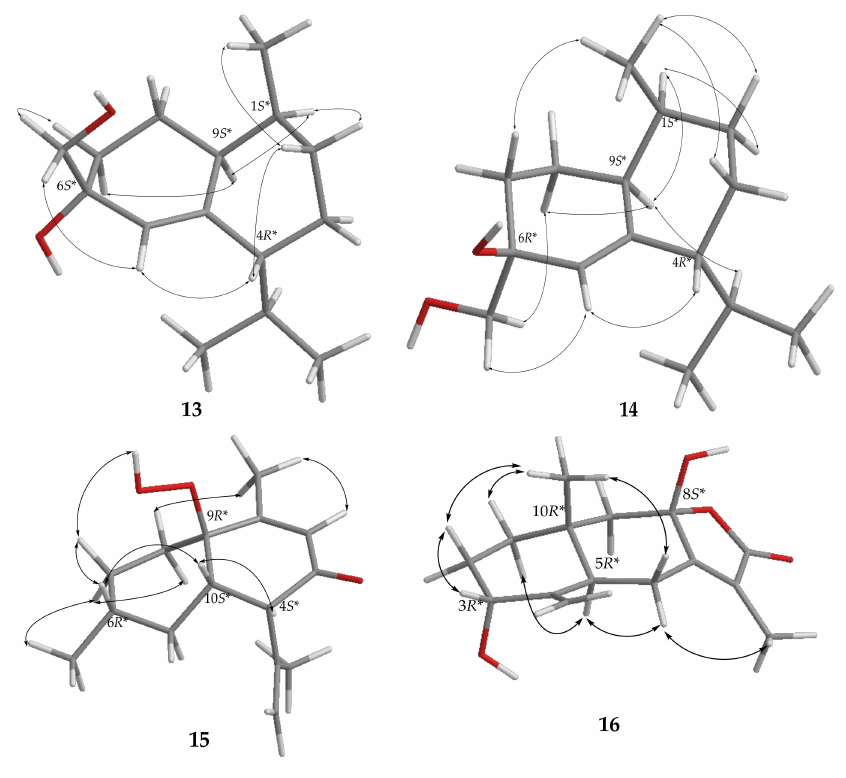
Figure 11. Selected NOE correlations of compounds 13 – 16 . The HRESIMS data of cespilin B ( 14 ) ( m / z 261.1824 [M + Na] + ) established a